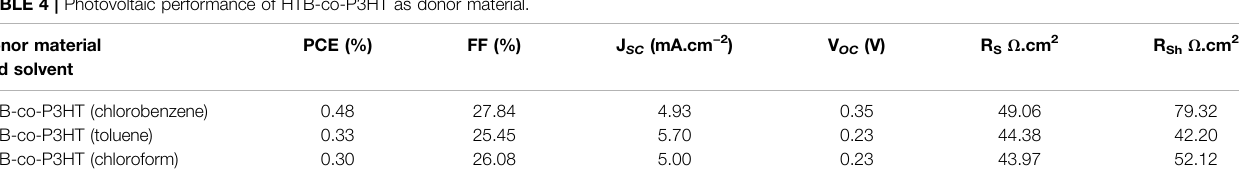
TABLE 4 | Photovoltaic performance of HTB-co-P3HT as donor material. Donor material PCE (%) FF (%) J SC (mA.cm − 2 ) V OC (V) R S Ω .cm 2 R Sh Ω .cm 2 and solvent HTB-co-P3HT (chlorobenzene)